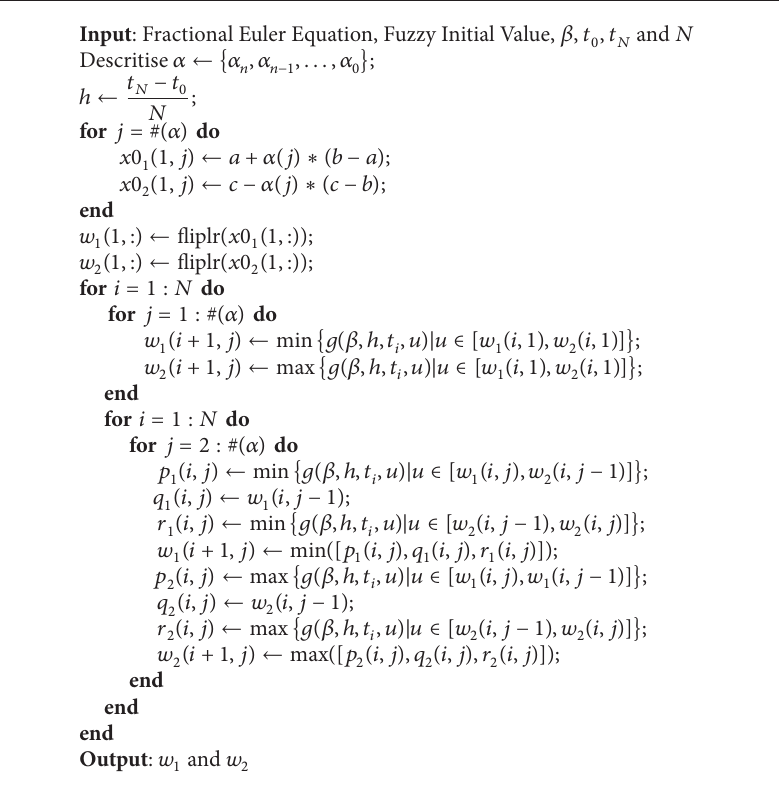
Algorithm 2: Fuzzy fractional Euler method for a nonlinear